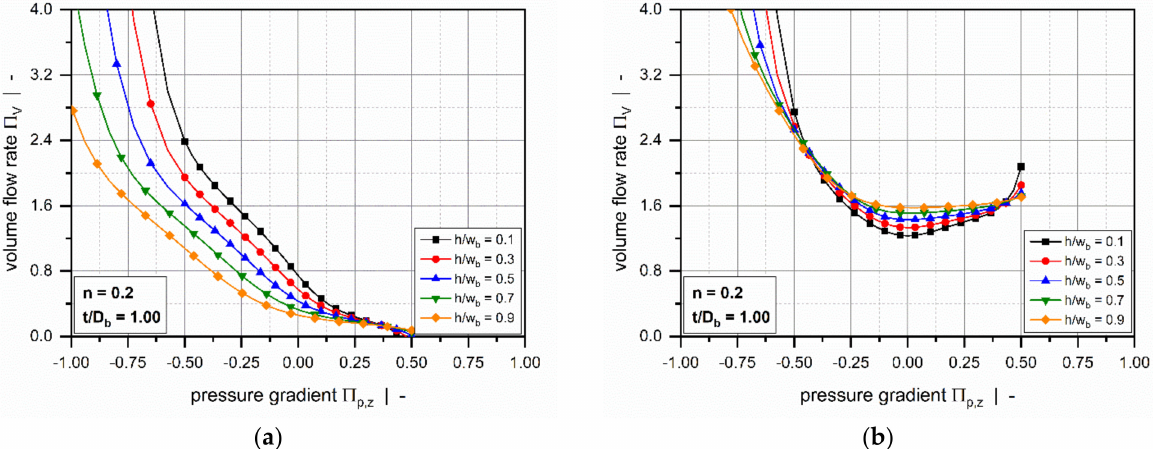
Figure 11. Influence of the aspect ratio on a fully developed three-dimensional flow of a power-law fluid in a screw channel of finite width under isothermal conditions. The dimensionless volume flow rate Π V as a function of the dimensionless pressure gradient Π p , z ( a ), and the dimensionless dissipation Π Q as a function of the dimensionless pressure gradient Π p , z ( b